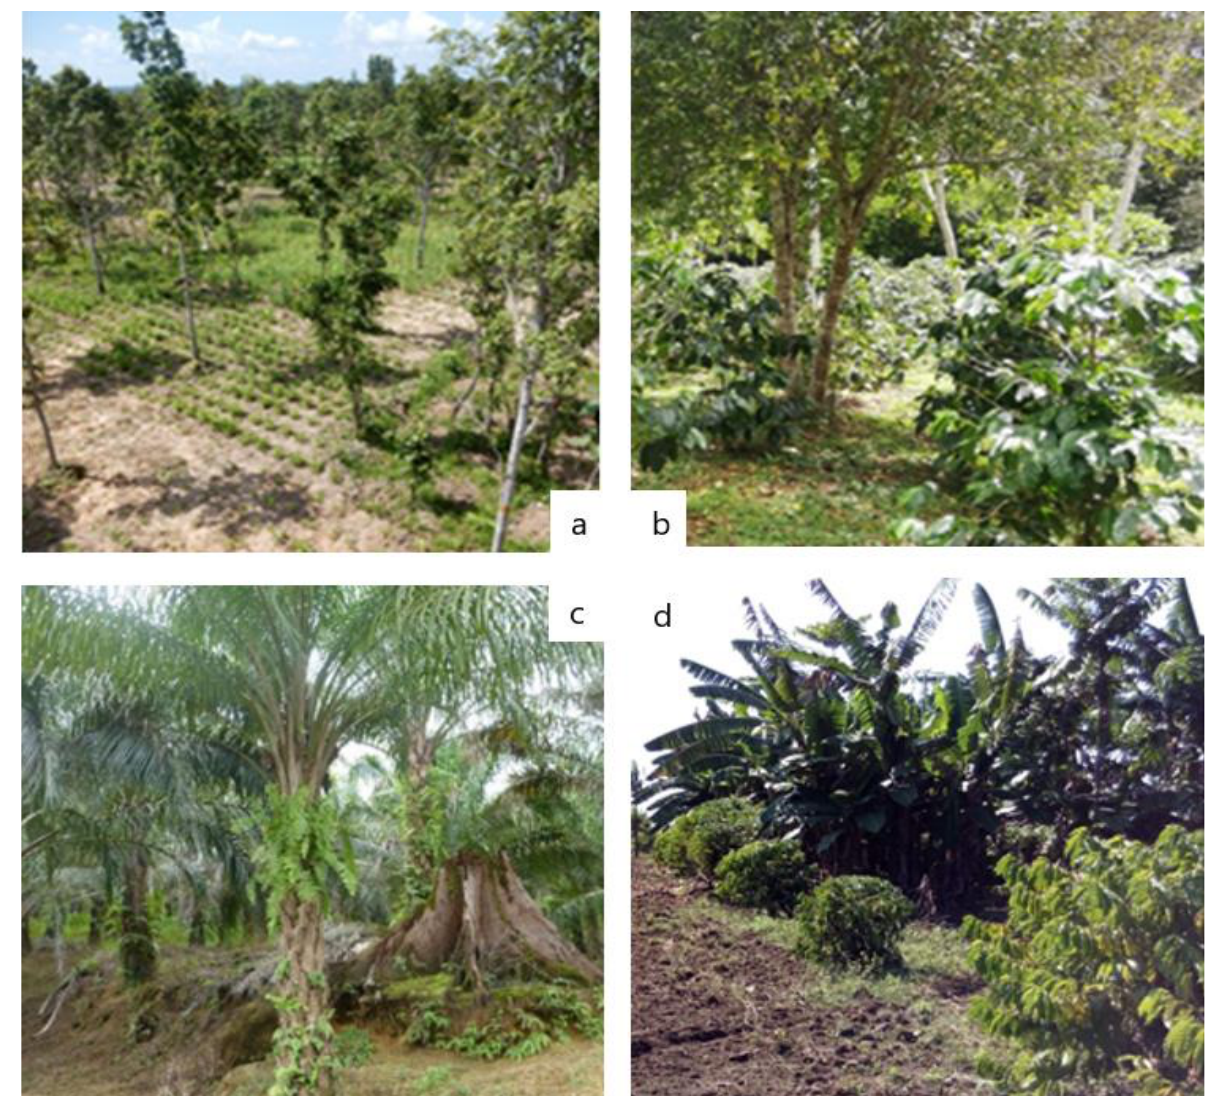
Figure 2. Examples from studied areas: ( a ) Cambodia; ( b ) Peru; ( c ) Indonesia; ( d ) Brazil.